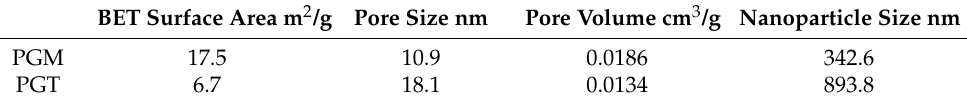
Table 4. Textural properties of the PGM and PGT